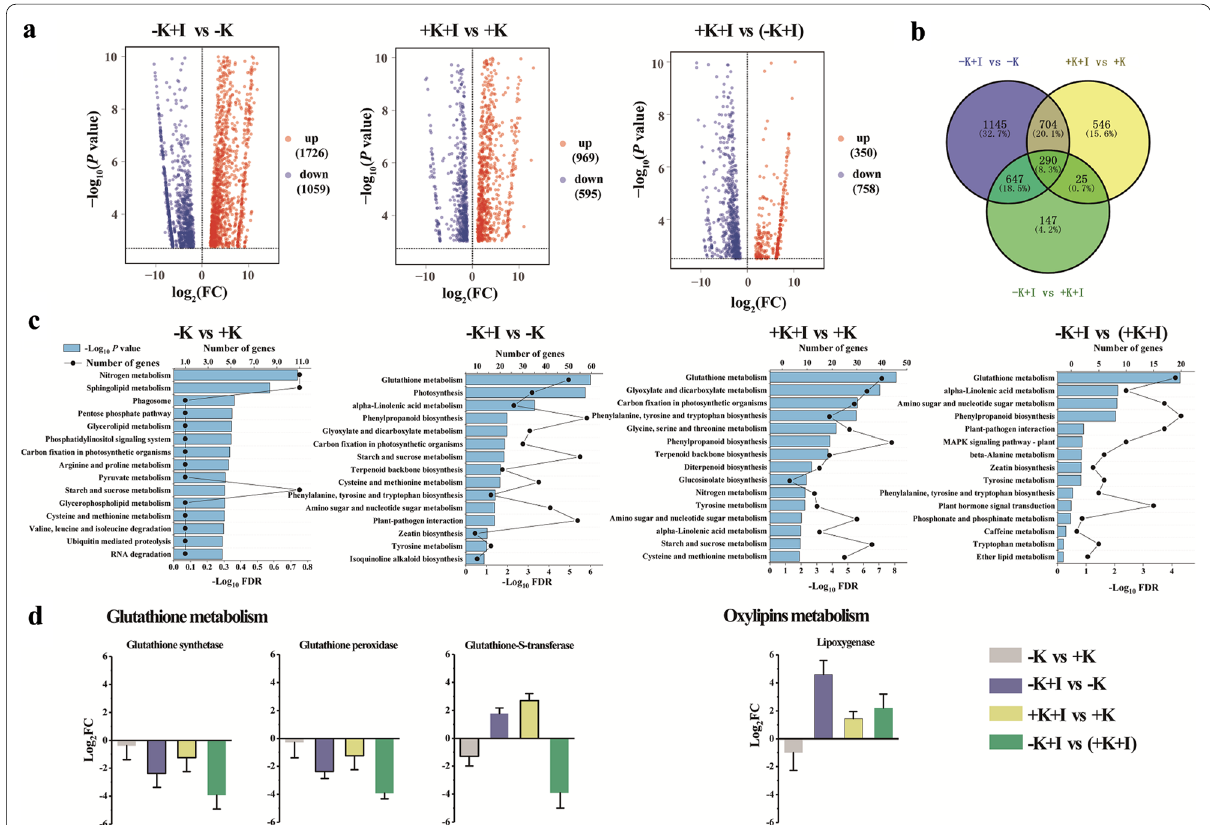
Fig. 5 The rice transcriptome is significantly altered by S. oryzae infection under both K-starvation and K-rich conditions. a Volcano plots showing the up- and down-regulated genes in K-starved and K-sufficient rice upon S. oryzae infection. b Numbers of overlapped transcripts in diseased and healthy plants under K-rich and K-starvation conditions. c KEGG enrichment of DEGs between K-starved and K-sufficient rice under both infected and non-infected conditions. The glutathione and lipid metabolism pathways were obviously enriched in K-starved rice under S. oryzae infection. d Log 2 (FC) values of representative transcripts from specific KEGG pathways (see c ). Treatments in brackets were performed as the